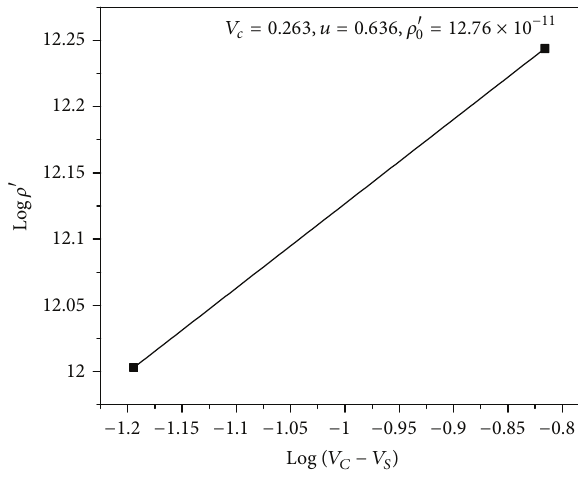
Figure 8: Log-log plot of 𝜌 󸀠 versus ( 𝑉 𝐶 − 𝑉 𝑆